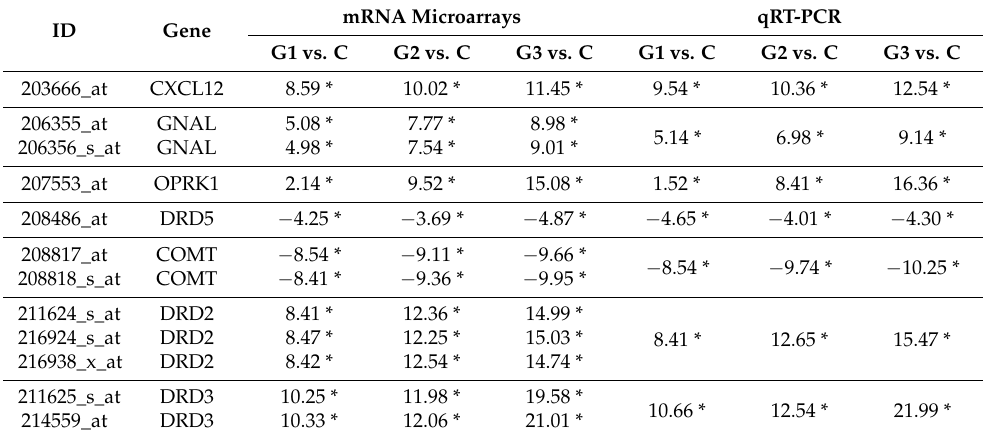
Table 1. Dopamine-related gene expression profile in endometrial cancer determined by microarrays and qRT-PCR ( p < 0.05).